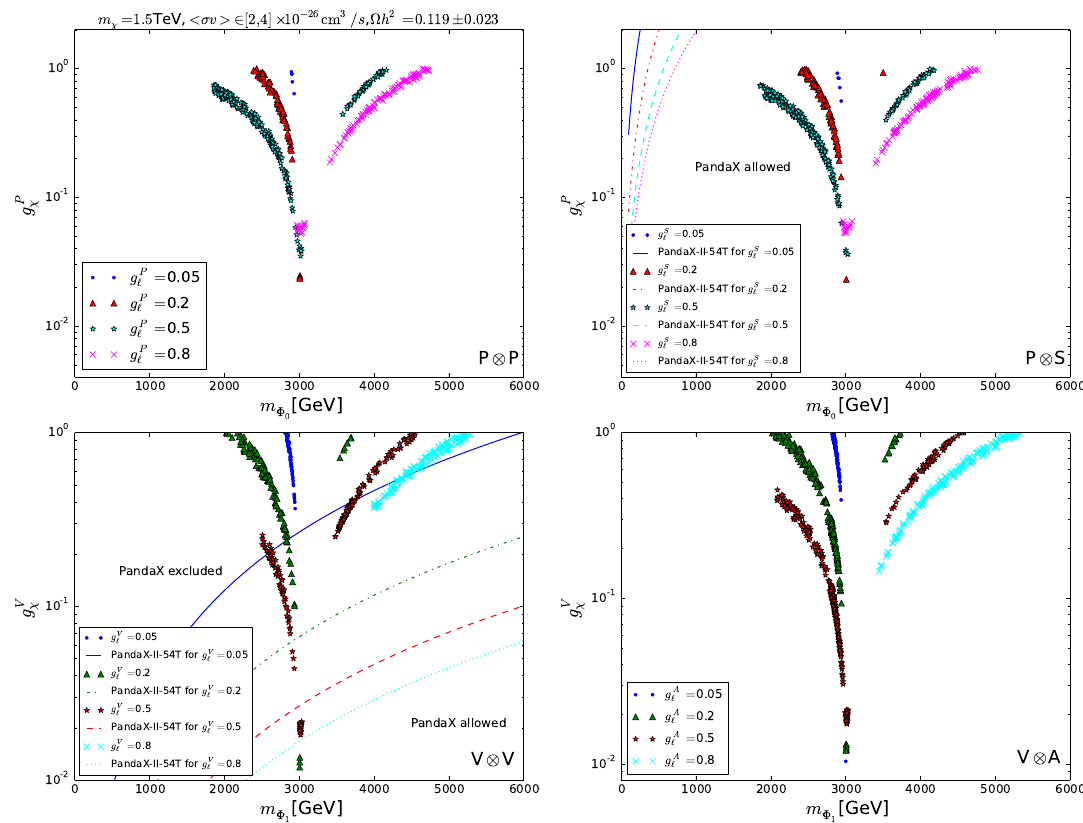
Figure 4 . Scatter plots of the samples satisfying the DM relic density within 2 (cid:27) range of Planck observed value, LEP bound and the DAMPE excess, projected on the plane of g (cid:31) versus m (cid:8) for g ‘ = 0 : 05 ; 02 ; 0 : 5 ; 0 : 8. All samples are required to produce averaged annihilation cross-section h (cid:27)v i today within (2 (cid:0) 4) (cid:2) 10 (cid:0) 26 cm 3 =s . The 90% C.L. exclusion limits from the current PandaX-II data is also shown